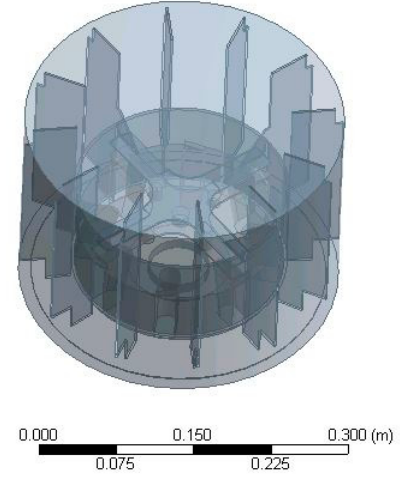
Figure 2 . Fluid domain.